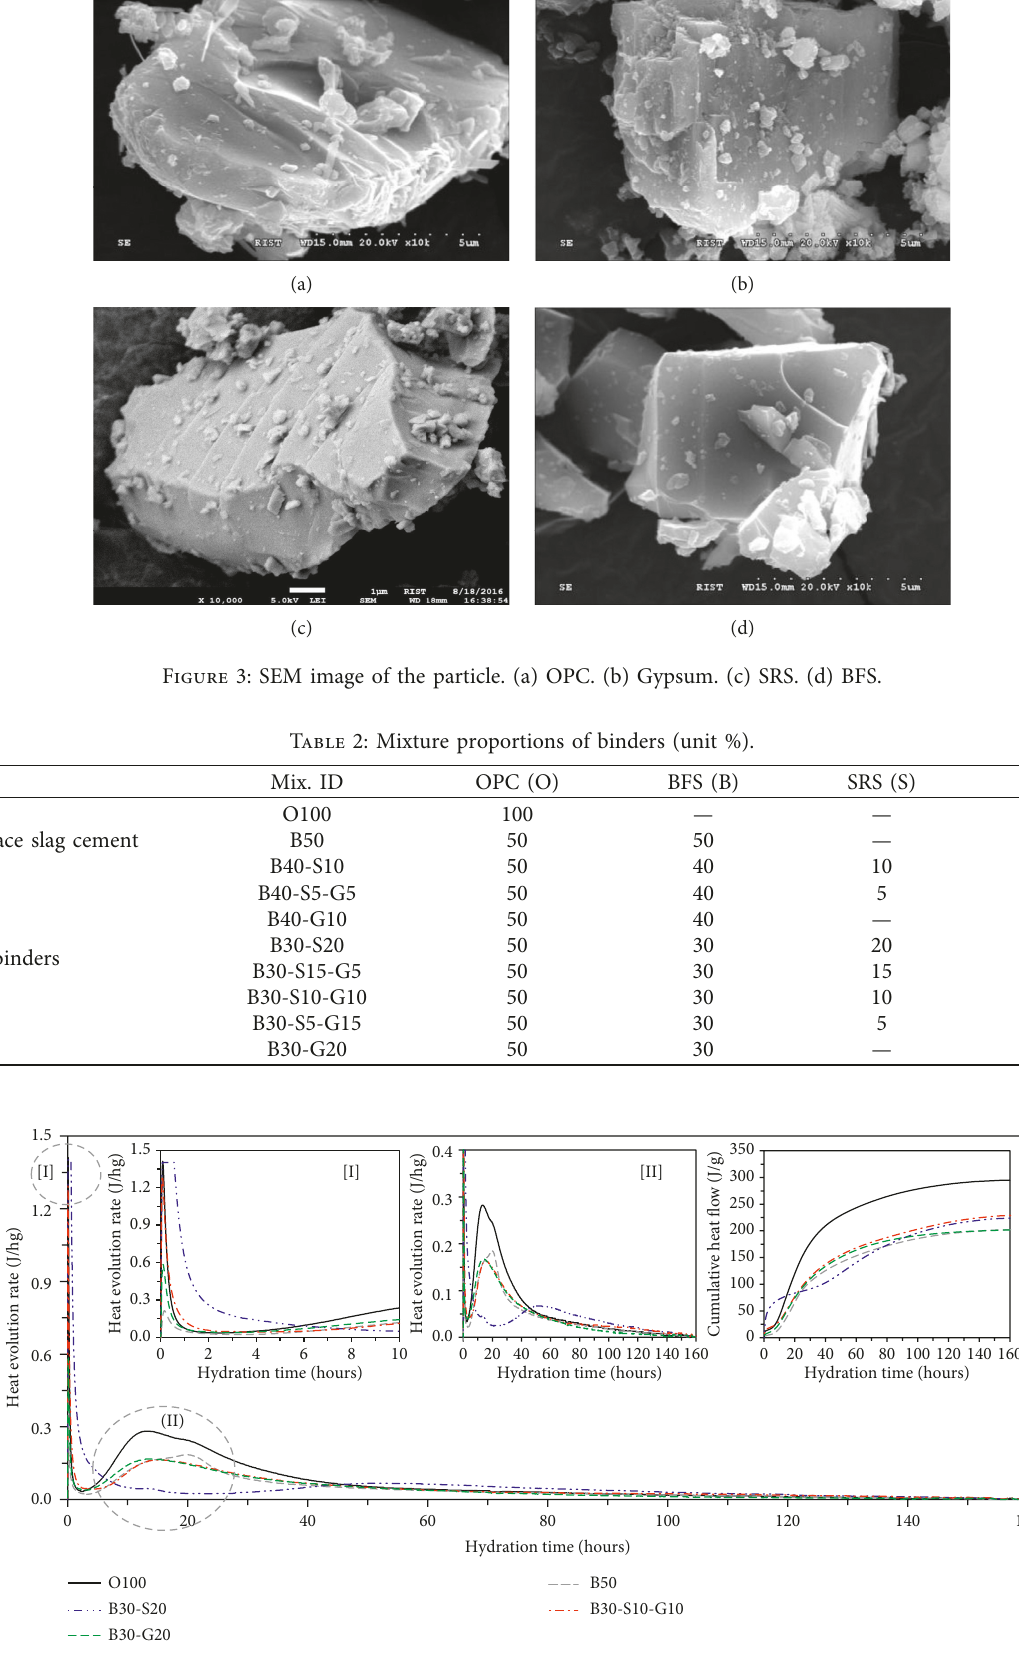
Figure 4: Hydration heat evolution with binder